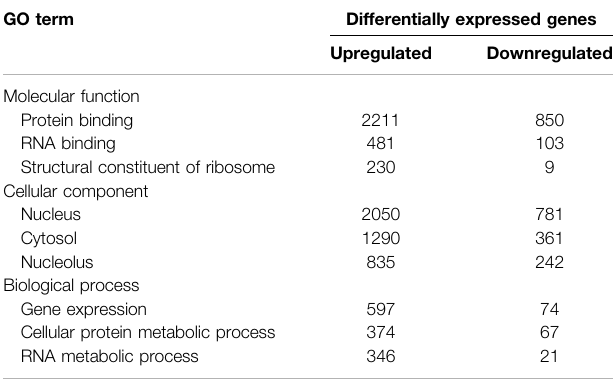
TABLE 1 | Gene ontology analysis of differentially expressed genes in molecular function, cellular component and biological process. GO term